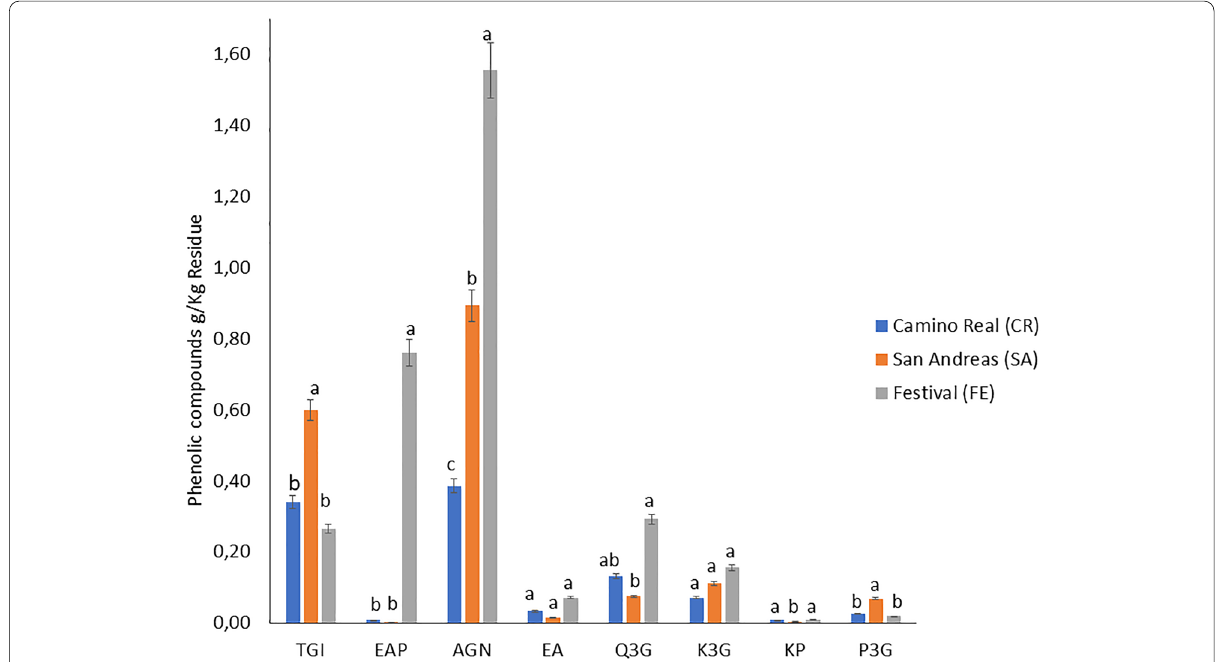
Fig. 4 Quantification of phenolic compounds from strawberry by‑products. TGI tetragalloyl‑glucose isomer, EAP ellagic acid pentoside, AGN agrimoniin, EA free ellagic acid, Q3G quercetin‑3‑ O ‑glucuronide, K3G kaempferol‑3‑ O ‑glucuronide, KP kaempferol pentoside, P3G